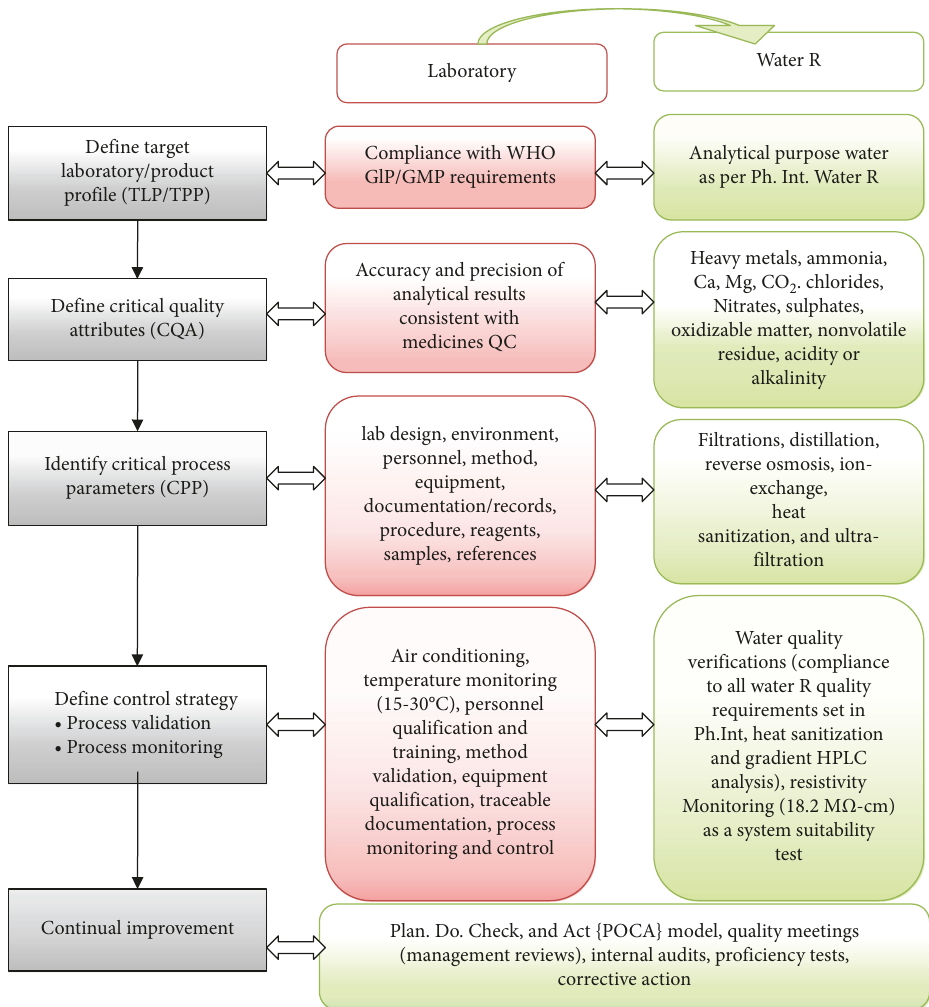
Figure 2: Lab QbD workflow and its application to lab water (GLP: good laboratory practice; GMP: good manufacturing practice).